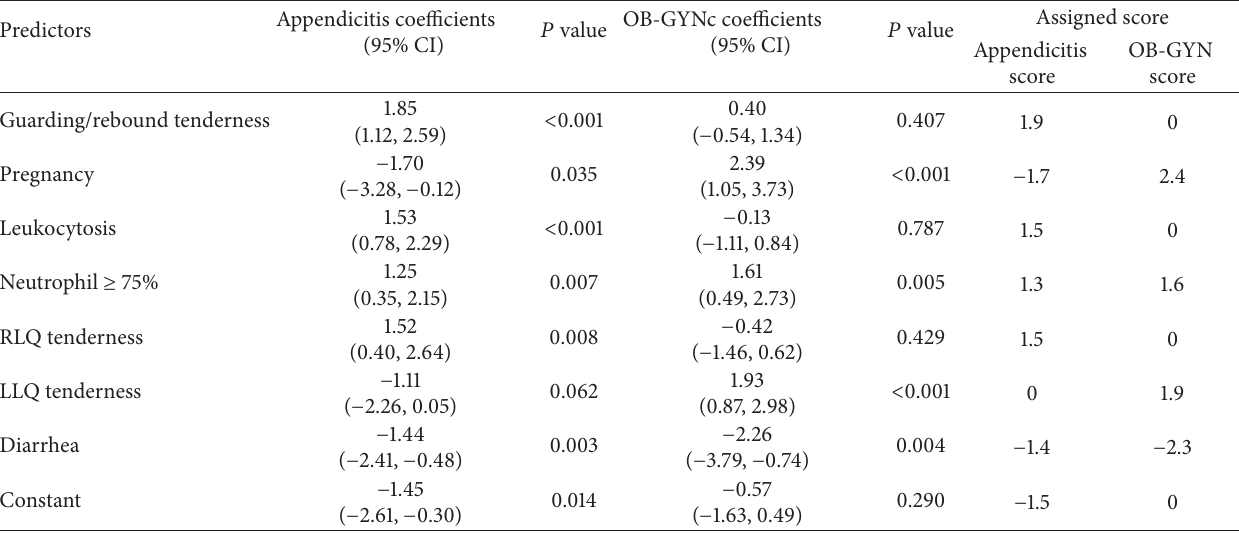
Table 2: Coefficients (95% confidence interval: CI) and assigned item scores of selected predictors for diagnosis of appendicitis or common obstetrics and gynecological conditions (OB-GYNc), from polynomial logistic regression analysis ∗ .